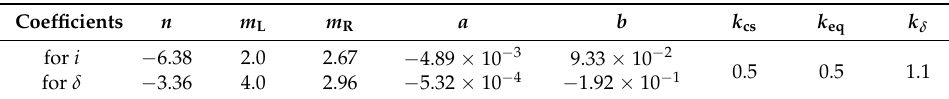
Table 4. Constant coefficients for the basic correlations.